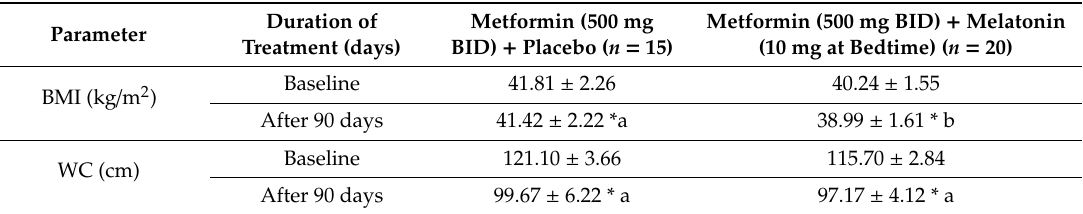
Table 7. Effect of treatment with metformin-melatonin versus metformin-placebo on the BMI and waist circumference (WC) in MEBS patients. Table 7. E ff ect of treatment with metformin-melatonin versus metformin-placebo on the BMI and waist circumference (WC) in MEBS patients.